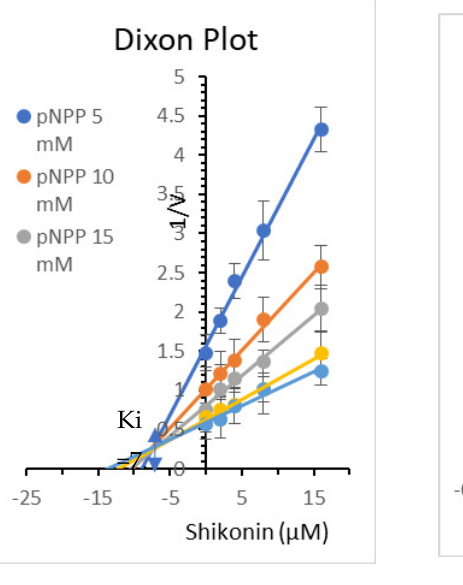
Supplementary Materials: The following are available online. Table S1: Computational parameters of pharmacokinetics (ADME) of Shikonin pharmacophores as calculated by ADMET Descriptor; Table S2: Computed computational values for Shikonin and its pharamacophores using Biovia Discovery Studio version 4.5.